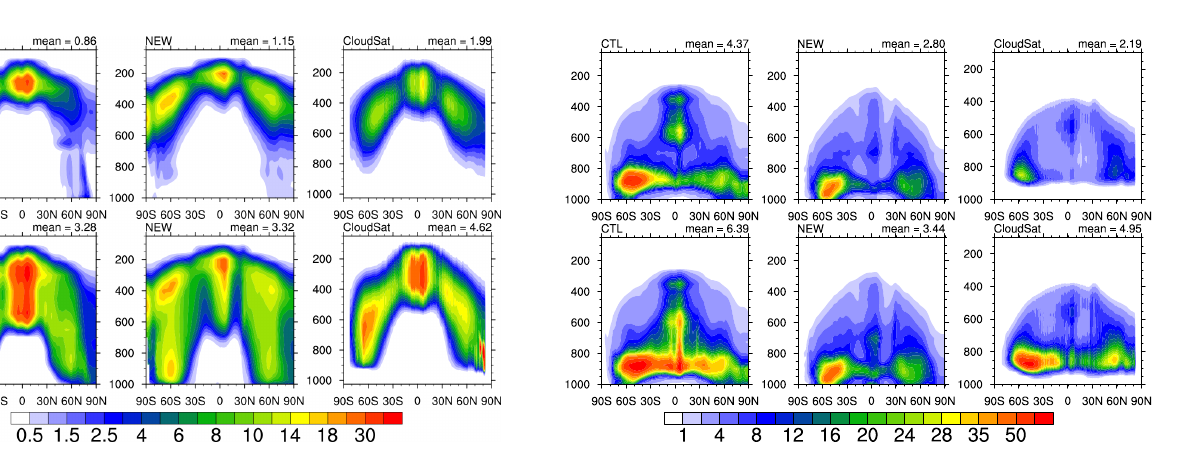
Figure 9. Zonal mean non-convective liquid water mass mixing ra- tio (mgkg − 1 ) (upper panels) and total liquid condensate (water and rain, bottom panels) for non-convective clouds from the CTL and NEW runs and the CloudSat retrieval (Li et al., 2014). Model re- sults span over 10 years of simulation, whereas CloudSat retrievals are plotted for the period 2007 to